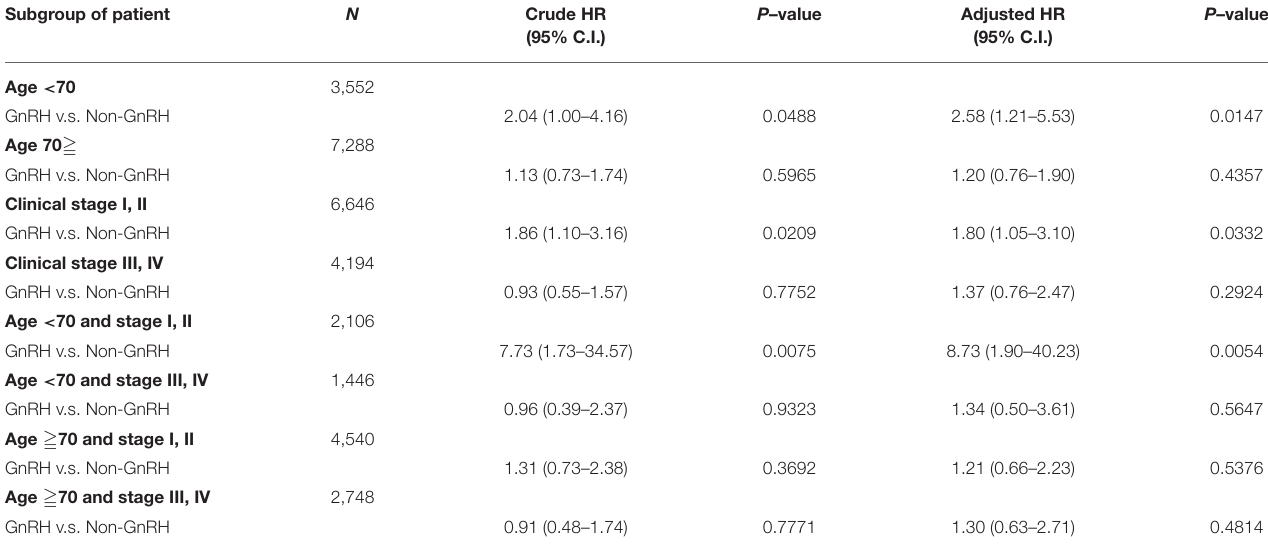
TABLE 3 | Subgroups analysis of risk factors of 5 years venous thromboembolic events (VTEs) between prostate cancer patients with and without gonadotropin-releasing hormone therapy (GnRH) uses. Subgroup of patient N Crude HR